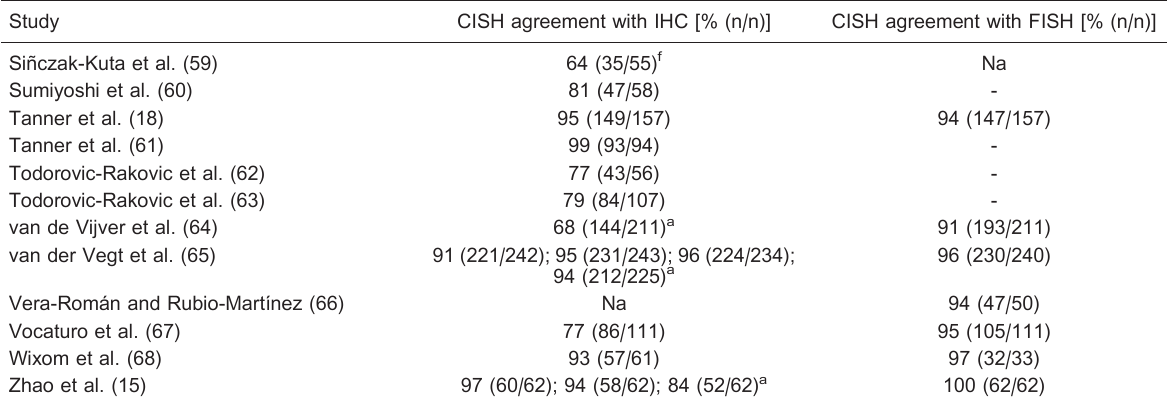
(53) and 93 and 100% (49) for 0/1 + and 3 + immunostain- ing, respectively. Rosa et al. (55) showed agreement in 85 and 100% of cases presenting IHC 0/1 + and 3 + , respectively. Putative explanations for SP3 false-negative cases are the loss of the extracellular domain due to HER2 cleavage and the shedding of the SP3 binding site, despite gene amplification by CISH (53) or gene over-